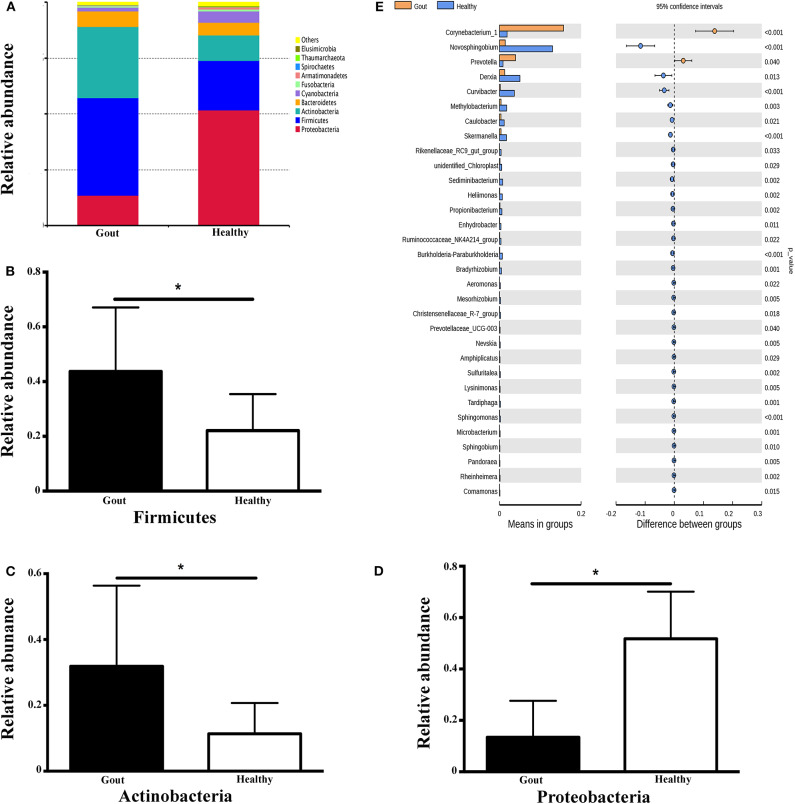
Microbiota composition at the phylum and genus levels. (A) Relative abundances of the 10 dominant bacterial phyla found across the two groups shown as histograms. A t-test was used to detect the difference between the two groups. (B–D) Phyla with significantly different relative abundances between two groups, *P <0.05. (E) Genus with significantly different relative abundances between two groups. Different genera were assigned only to those presenting minimum variation at a significance level of P <0.05.